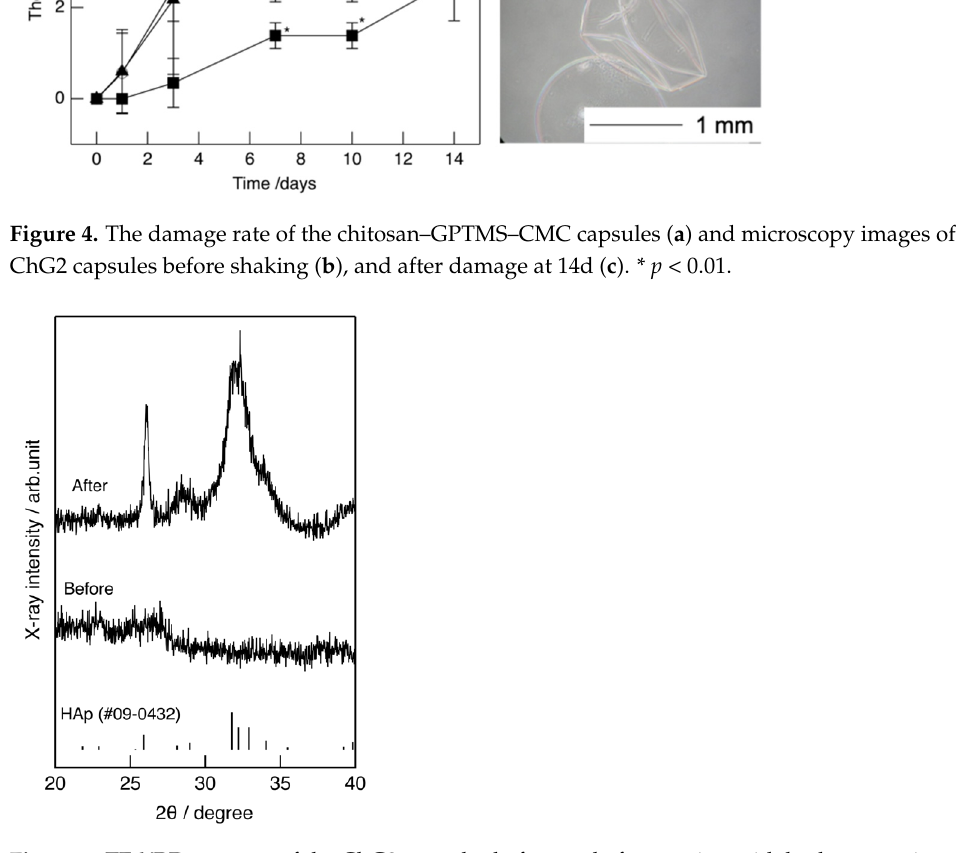
Figure 5. TF-XRD patterns of the ChG2 capsules before and after coating with hydroxyapatite.